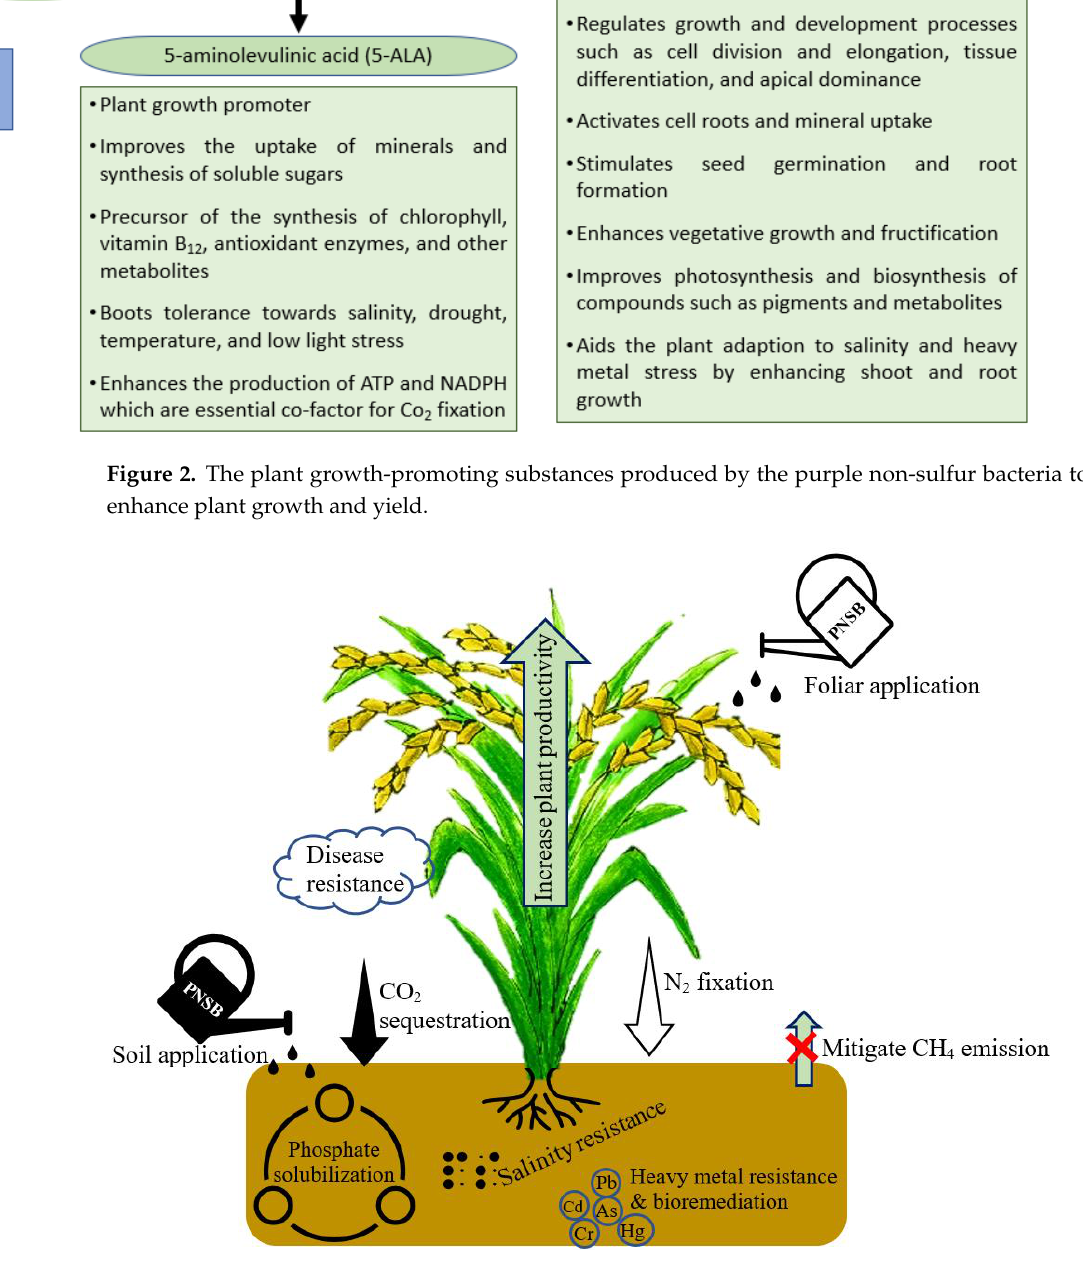
Figure 3. Summary of the benefits purple non-sulfur bacteria provides to the rice ecosystem when applied to soil or foliar.